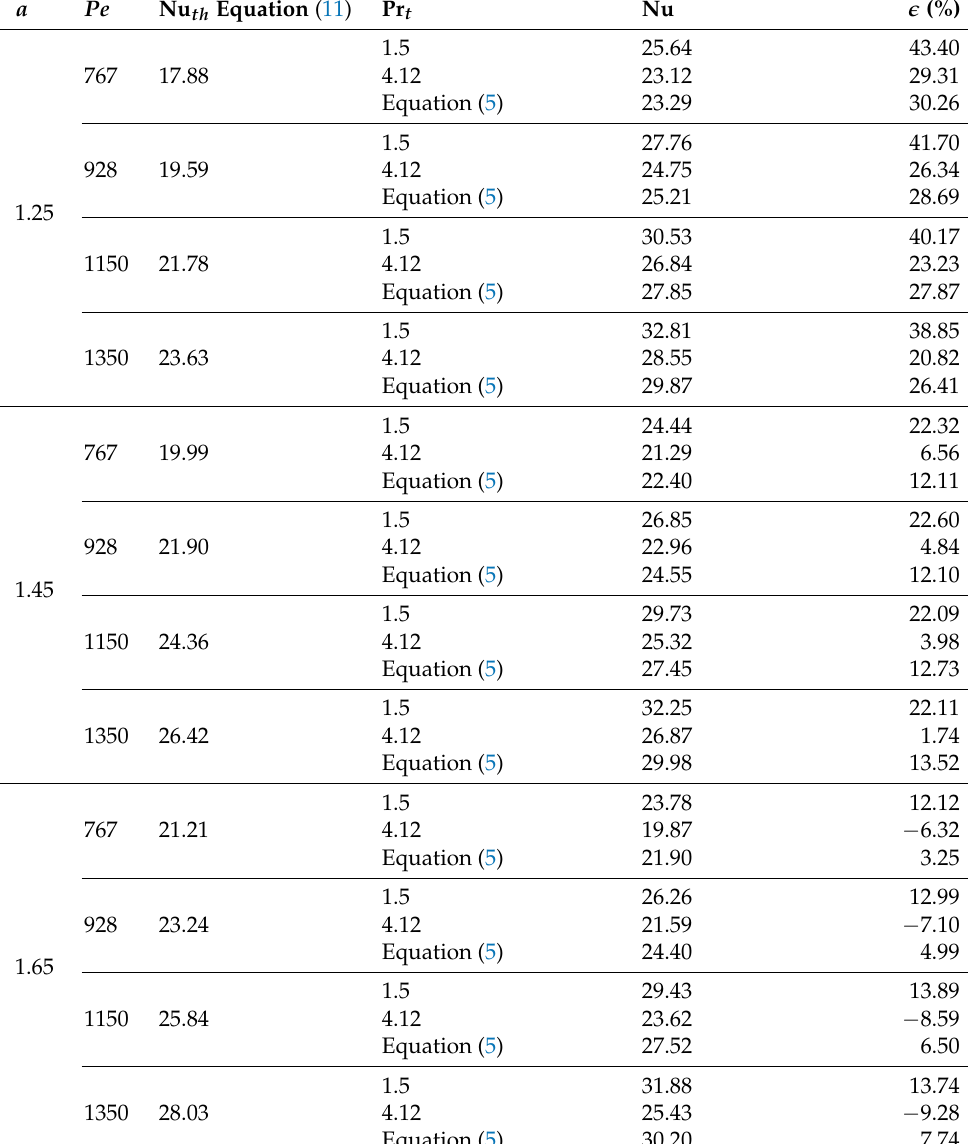
Table 6. Comparison between the bundle-averaged Nu, calculated with Equation (9), and reference values estimated with Equation (11) for the staggered bundle. Relative deviation (cid:101) = ( Nu − Nu th ) / Nu th